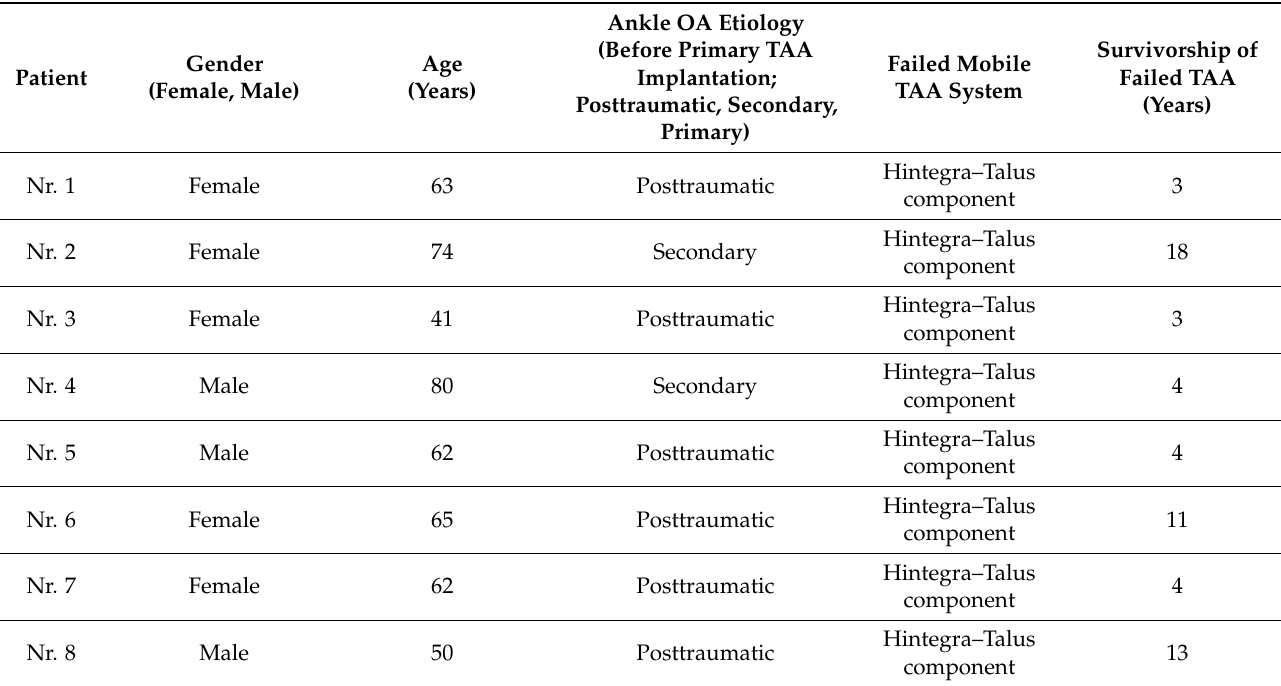
Table 1. Patients with Partial Failure of the Mobile-Bearing Total Ankle Arthroplasty (TAA), Failed Talar